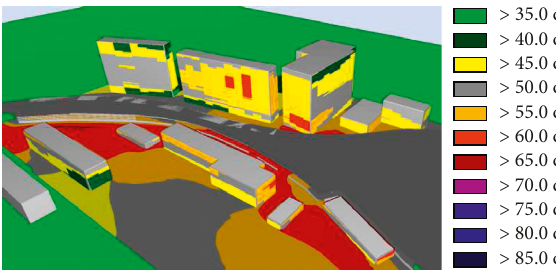
Figure 16: The map of calculated railway-induced noise.